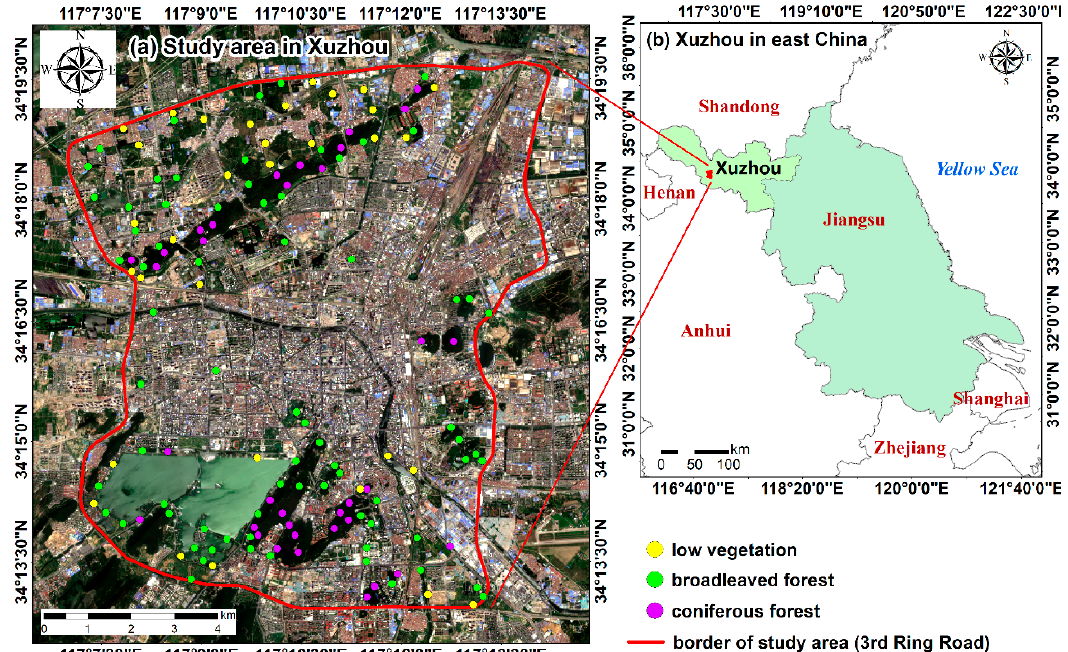
Figure 1. The location of the study area: ( a ) the border of the study area (i.e., the third ring road of Xuzhou) and the sites for field investigations (yellow for low vegetation, green for broadleaved forest, and purple for coniferous forest); ( b ) Xuzhou in east China.